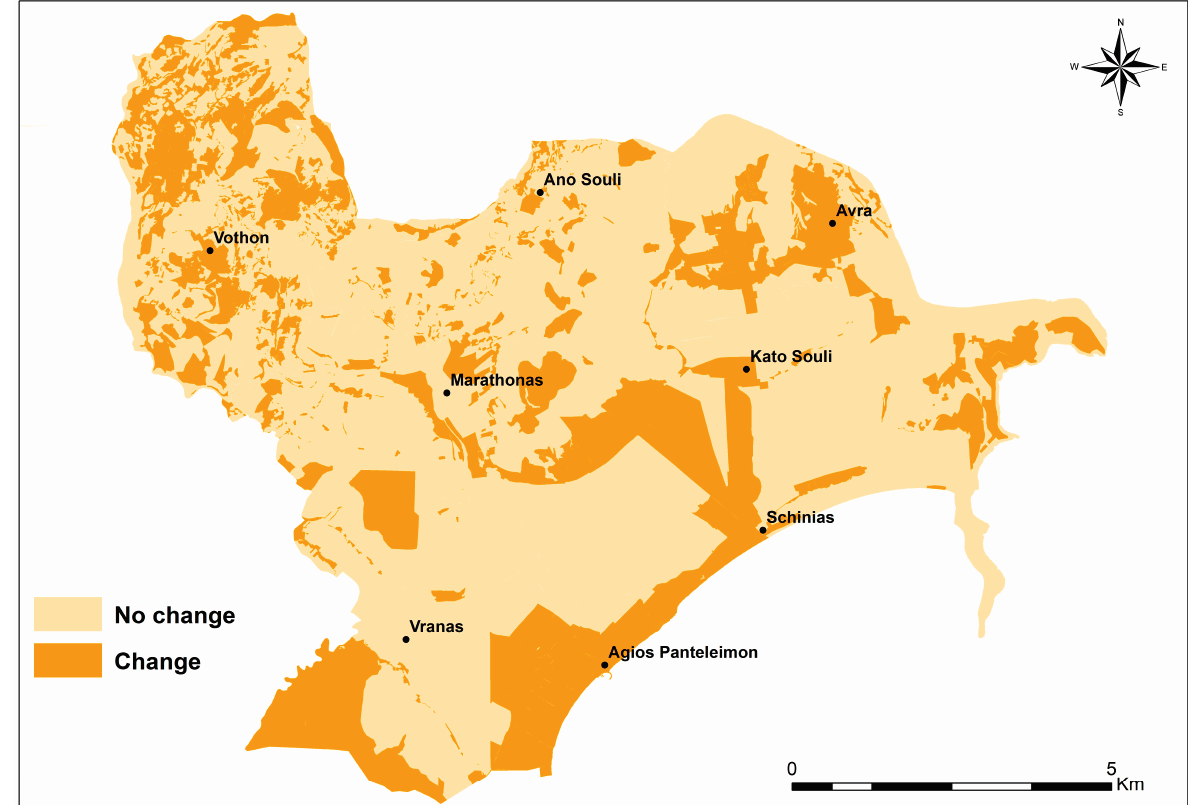
Figure 5. Distribution of sections of the change and no change areas in terms of land cover changes between 1945 and 2007.